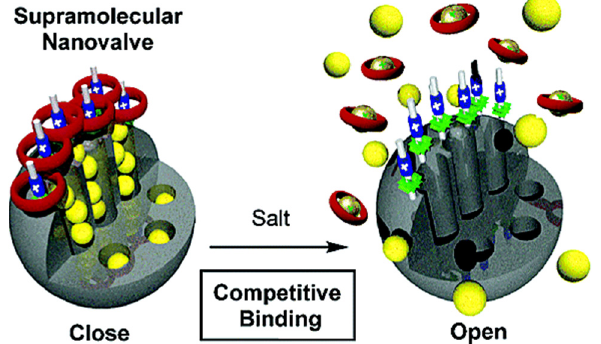
Figure 9. Graphical representation of operating supramolecular nanovalves from DB24C8/dialkylammonium-tethered porous silica particle MSNs. Reproduced with permission from [94]. Copyright American Chemical Society,